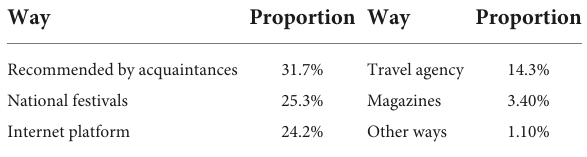
TABLE 4 Understanding pathway survey